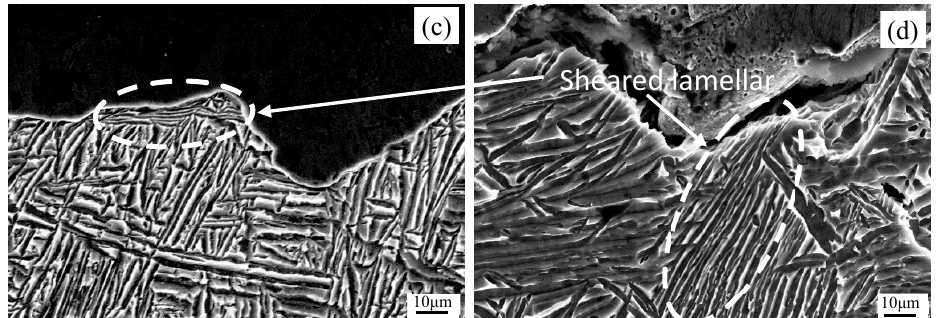
Figure 12. The typical fracture surface includes crack initiation region, crack propagation region shear lip region and microstructure near the fracture of the impact specimen at different aging temperatures for impact samples: ( a ) ( c ) 540 °C; ( b ) ( d ) 630 °C.